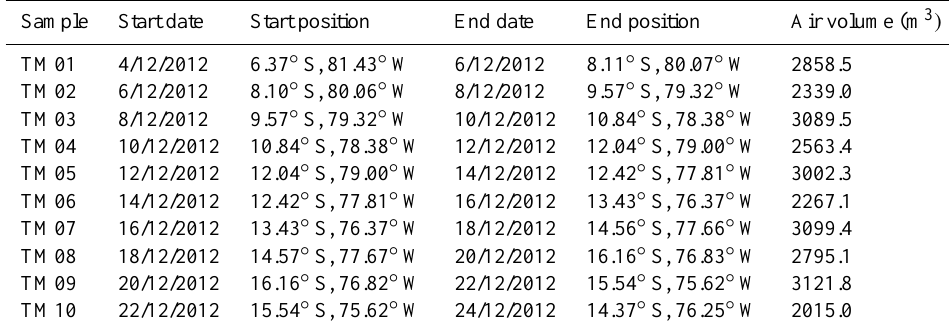
Table 1. Details of aerosol samples collected during the M91 cruise.